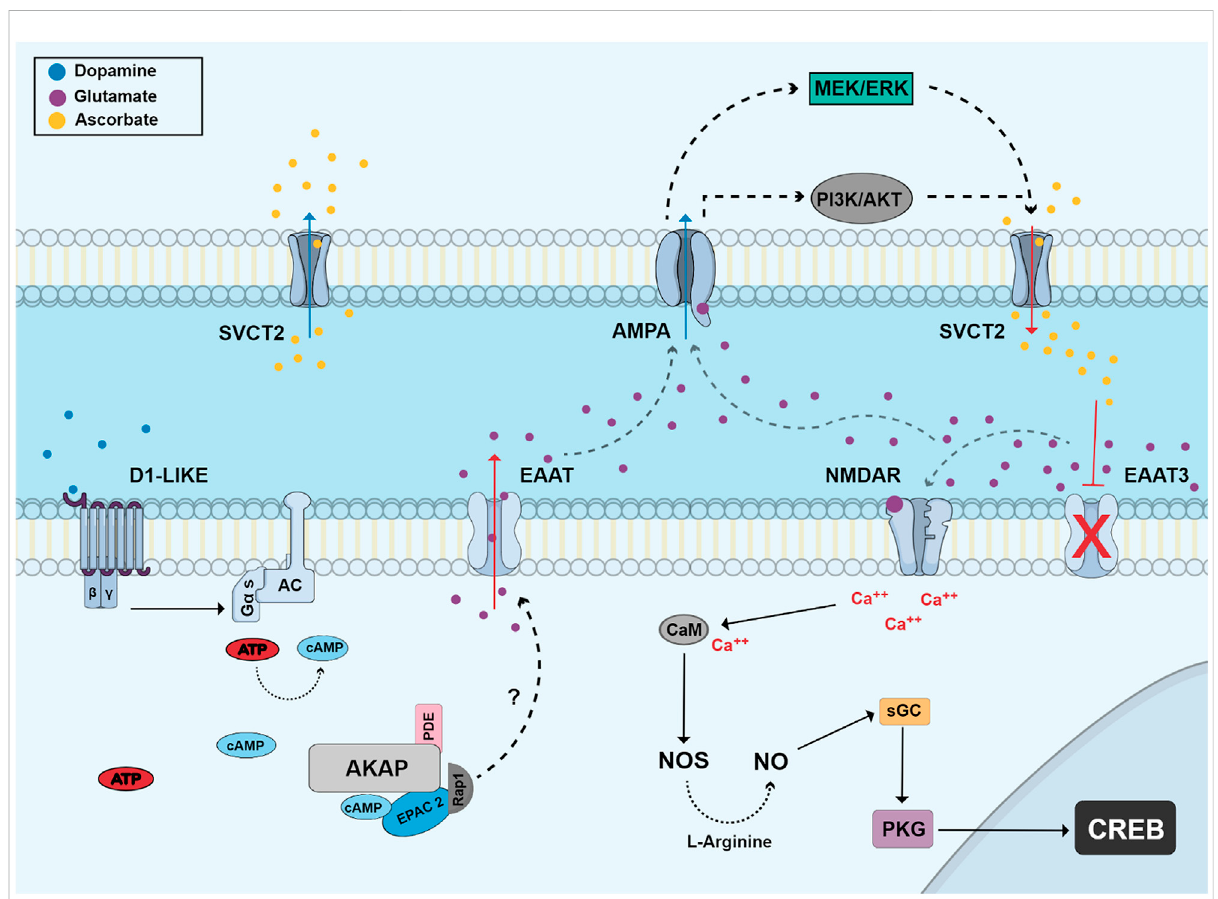
FIGURE 5 Dopamine regulates the release of vitamin C via EPAC and glutamate receptors. Dopamine stimulates D1-like receptors and activates adenylyl cyclase and cAMP production. cAMP stimulates EPAC2 and Rap1 which stimulates the release of glutamate by an unknown mechanism. Glutamate canthenstimulateAMPAreceptorsinasecondcellactivatingMEK/ERKandPI3K/AKTpathwaysandpromotingascorbateef fl uxthroughthesodium/ vitamin C transporter 2 (SVCT2). Extracellular ascorbate promotes an increase of extracellular glutamate by inhibiting EAAT3 activity and then glutamate can stimulate NMDA receptors (NMDAR). This activation leads to calcium in fl ux and increased NO production by calcium/calmodulin- dependent NOS, which then can stimulate the canonical PKG-dependent pathway and CREB